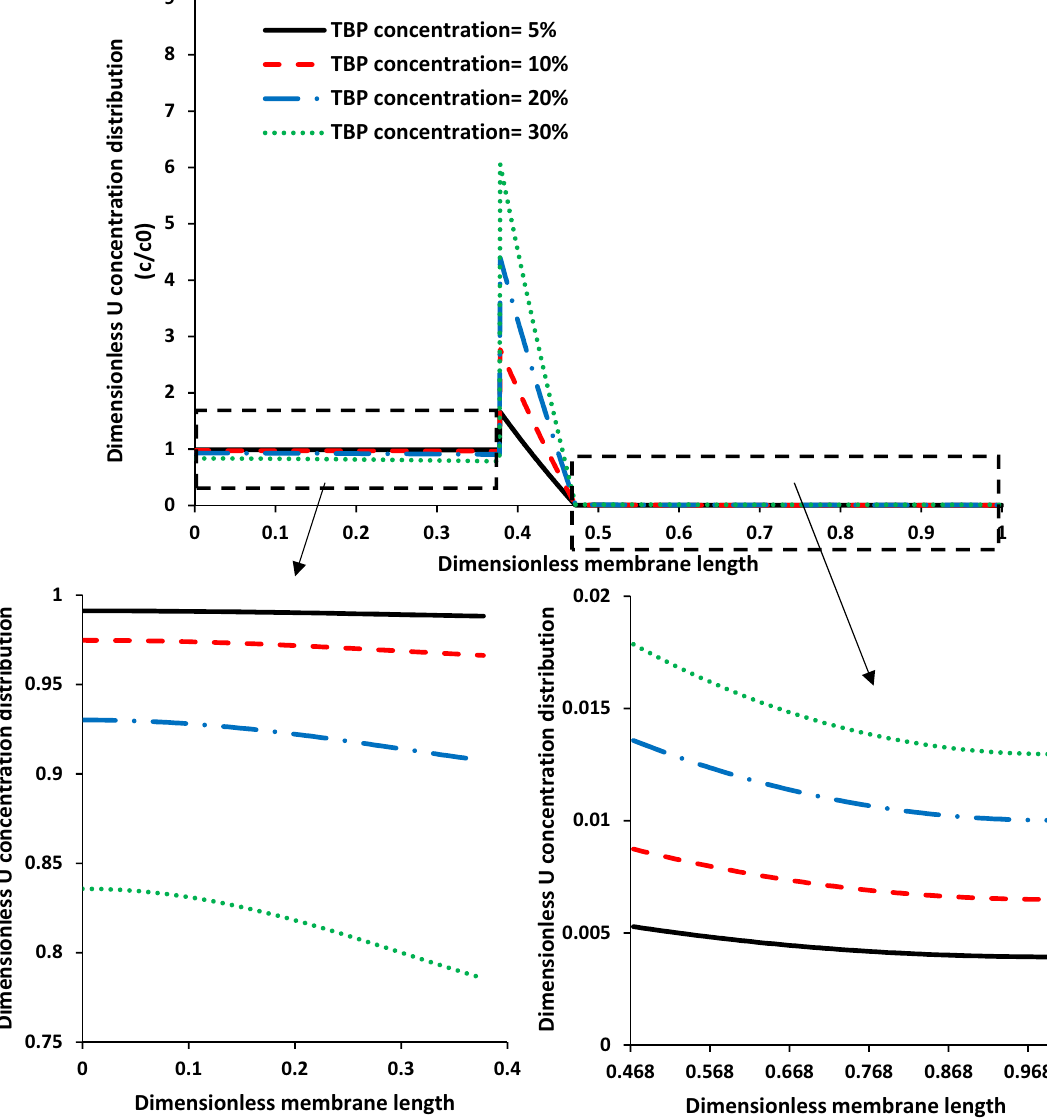
Figure 6. Dimensionless uranium concentration distribution in radial direction at different TBP